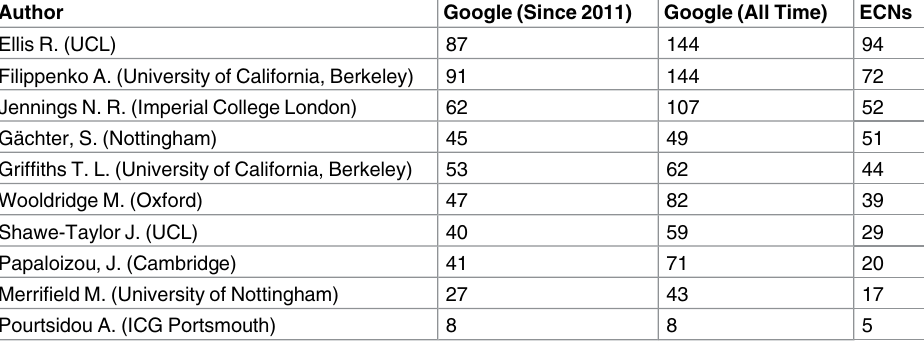
Table 2. Comparison of H-indices for Authors: Google vs ECNs.